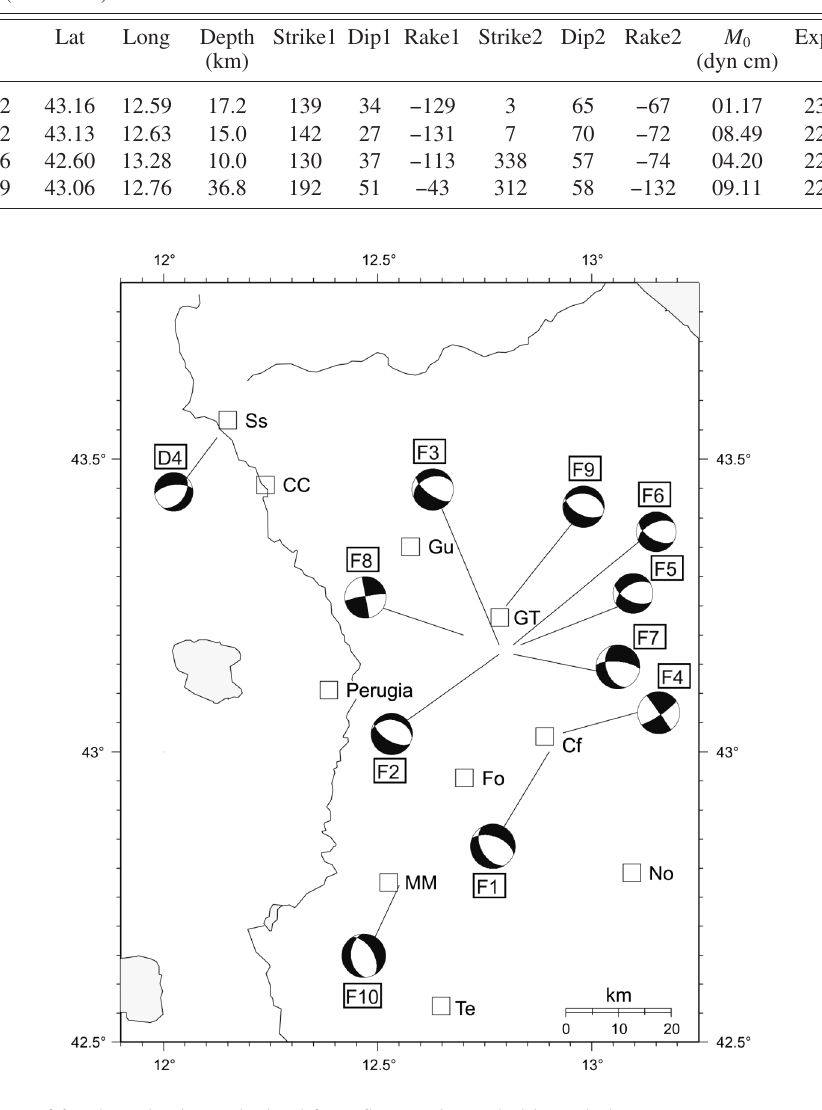
Fig. 5. Map of focal mechanisms obtained from first-motion polarities